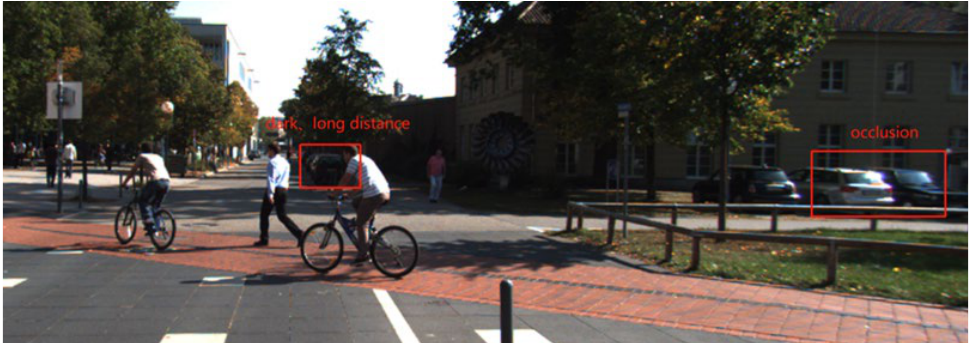
Figure 2. Typical scene from vehicle view.